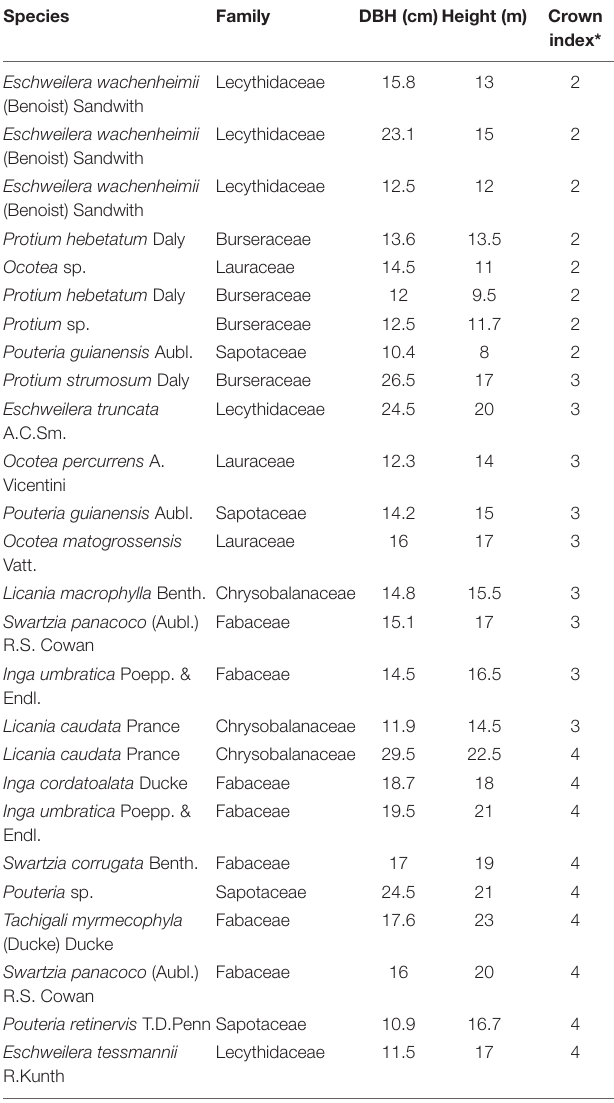
TABLE 1 | List of the 26 individuals studied and their corresponding species, diameter at breast height (DBH), total height and crown illumination index (Clark and Clark,